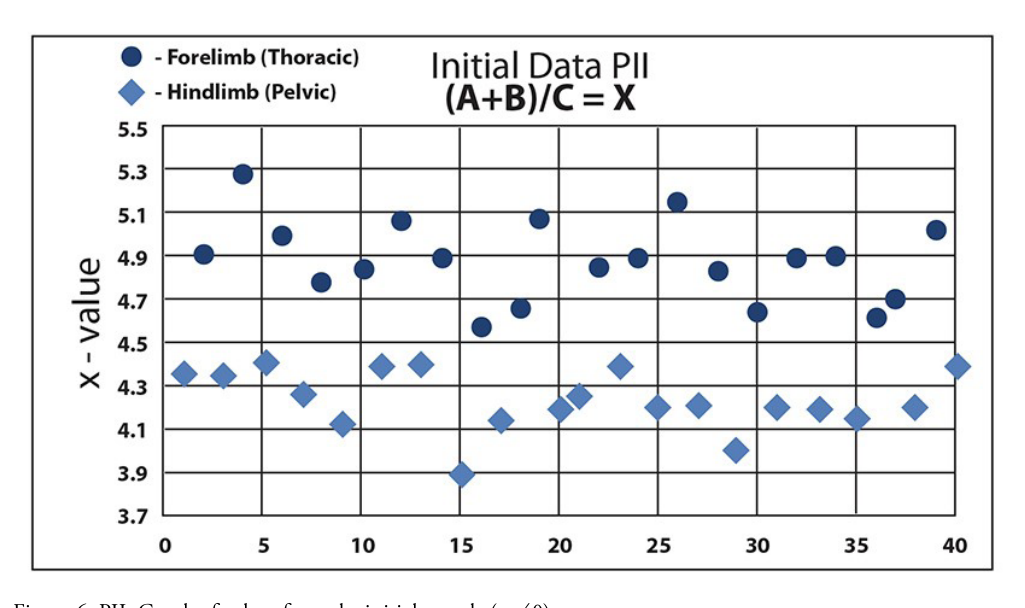
Figure 6. PII. Graph of values from the initial sample